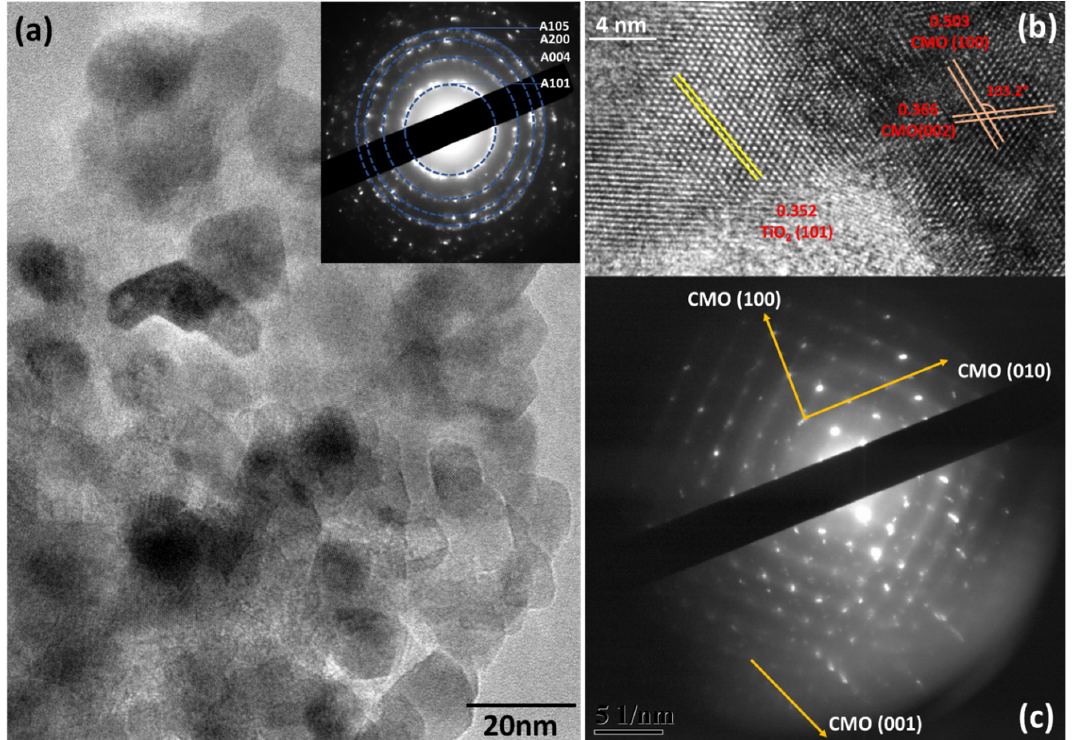
Figure 2. ( a ) TEM and ( inset , a ) corresponding SAED from the Ca x MnO y -TiO 2 samples. ( b ) HRTEM, and ( c ) SAED of Ca x MnO y -TiO 2